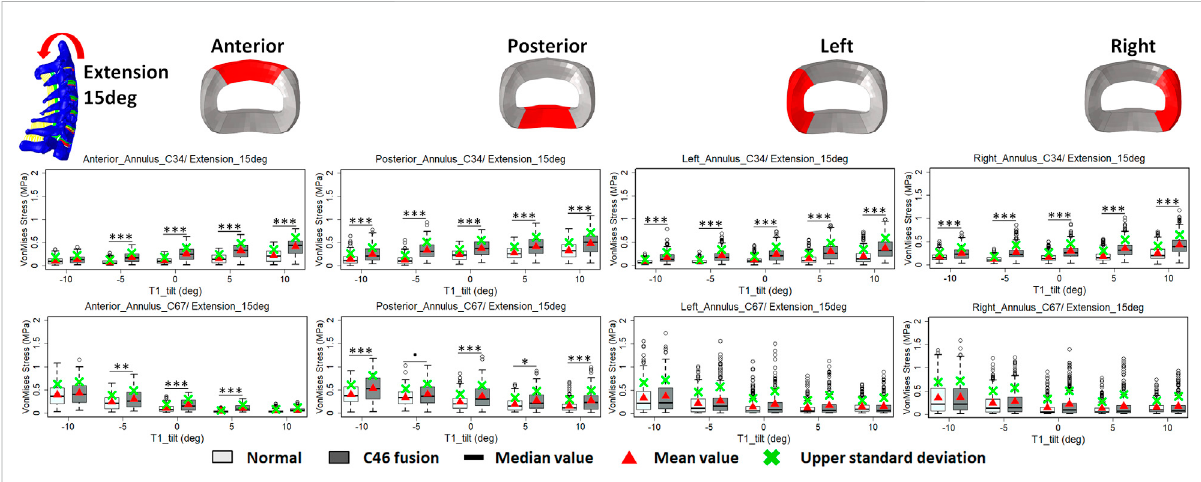
FIGURE 7 Comparison of average VonMises stress at different regions of annulus fi brosus at adjacent segments (C3 – 4 and C6 – 7) before and after C4 – 6 ACF with varying T1 tilt degrees under the 15 ° extension loading (Signi fi cance level of p value: ‘ *** ’ < 0.001; ‘ ** ’ < 0.01; ‘ * ’ < 0.05; ‘ . ’ < 0.1; ‘’ >